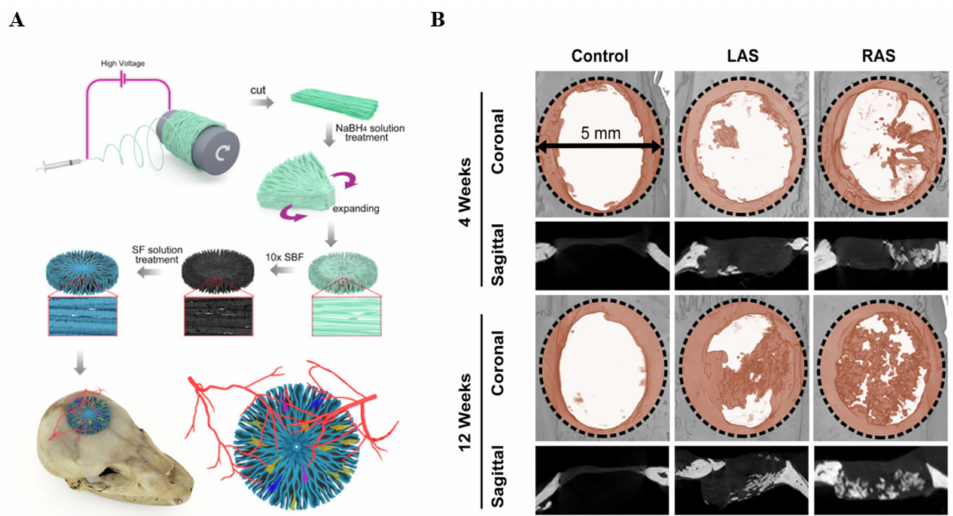
Figure 2. ( A ) Fabrication and application of the nanofiber scaffolds with SF and HAp coating; ( B ) Micro-CT images of the defect areas for 4 and 12 weeks. Reproduced with permission from [86]. Copyright 2021,